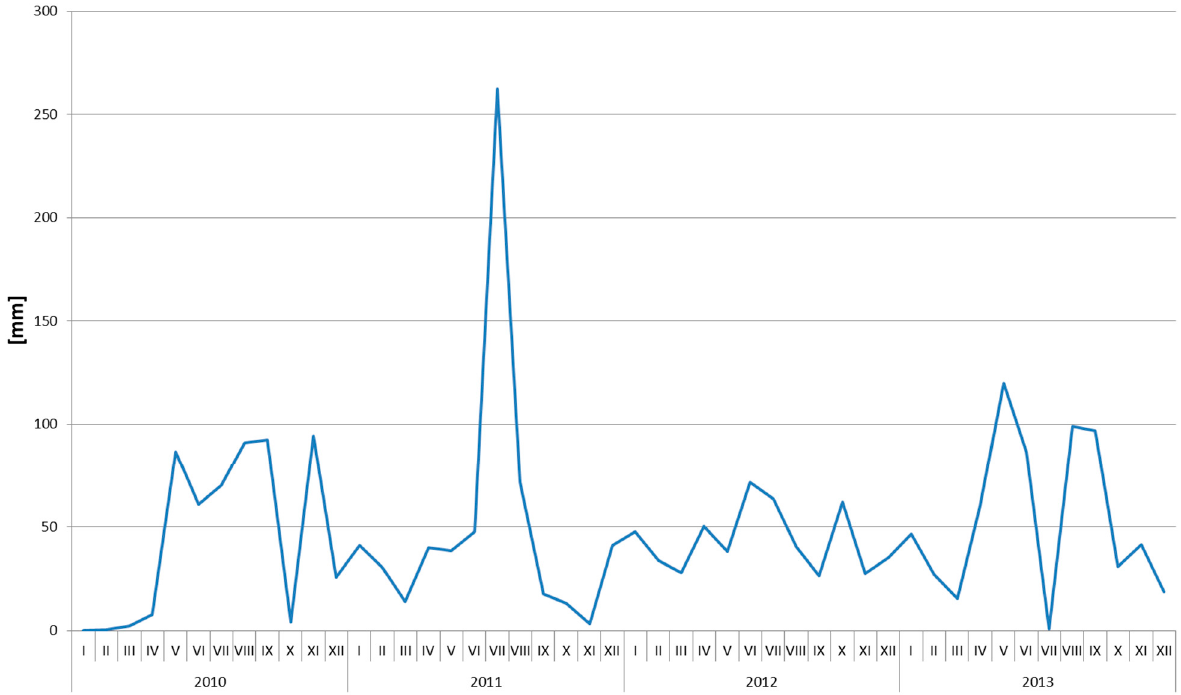
Figure 2. Precipitation on experiment area in years 2010–2013.